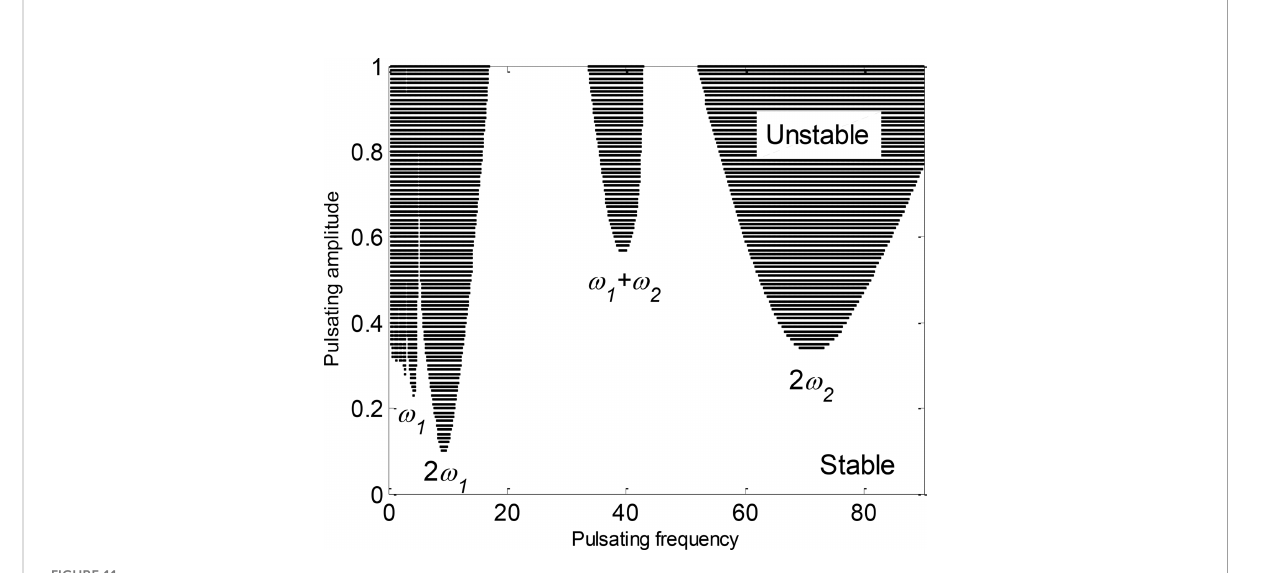
FIGURE 11 The parameter instability region diagram of the